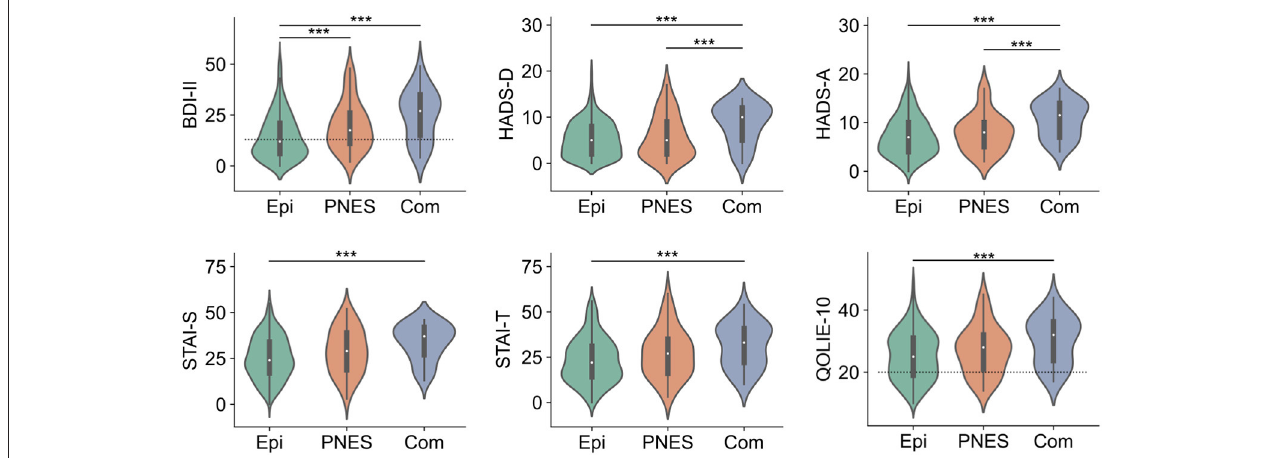
FIGURE 2 | Inventory scores according to the diagnostic group. Epi, epilepsy group; PNES, psychogenic non-epileptic seizure group; Com, combined group. *** p <